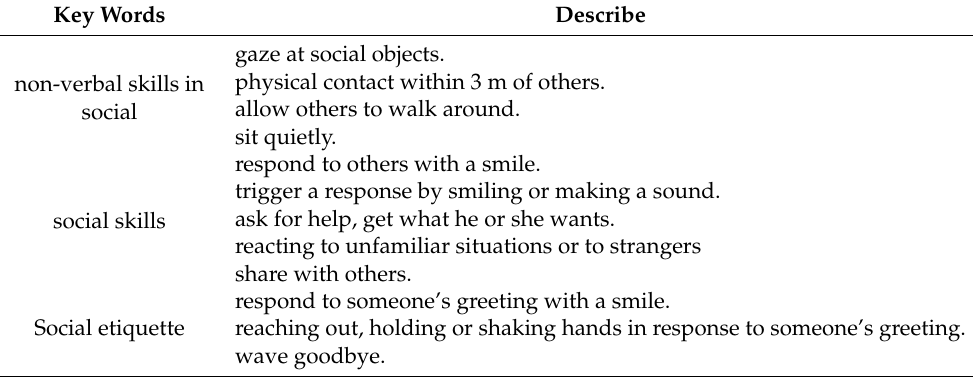
Table 2. Autism Children’s Development Assessment